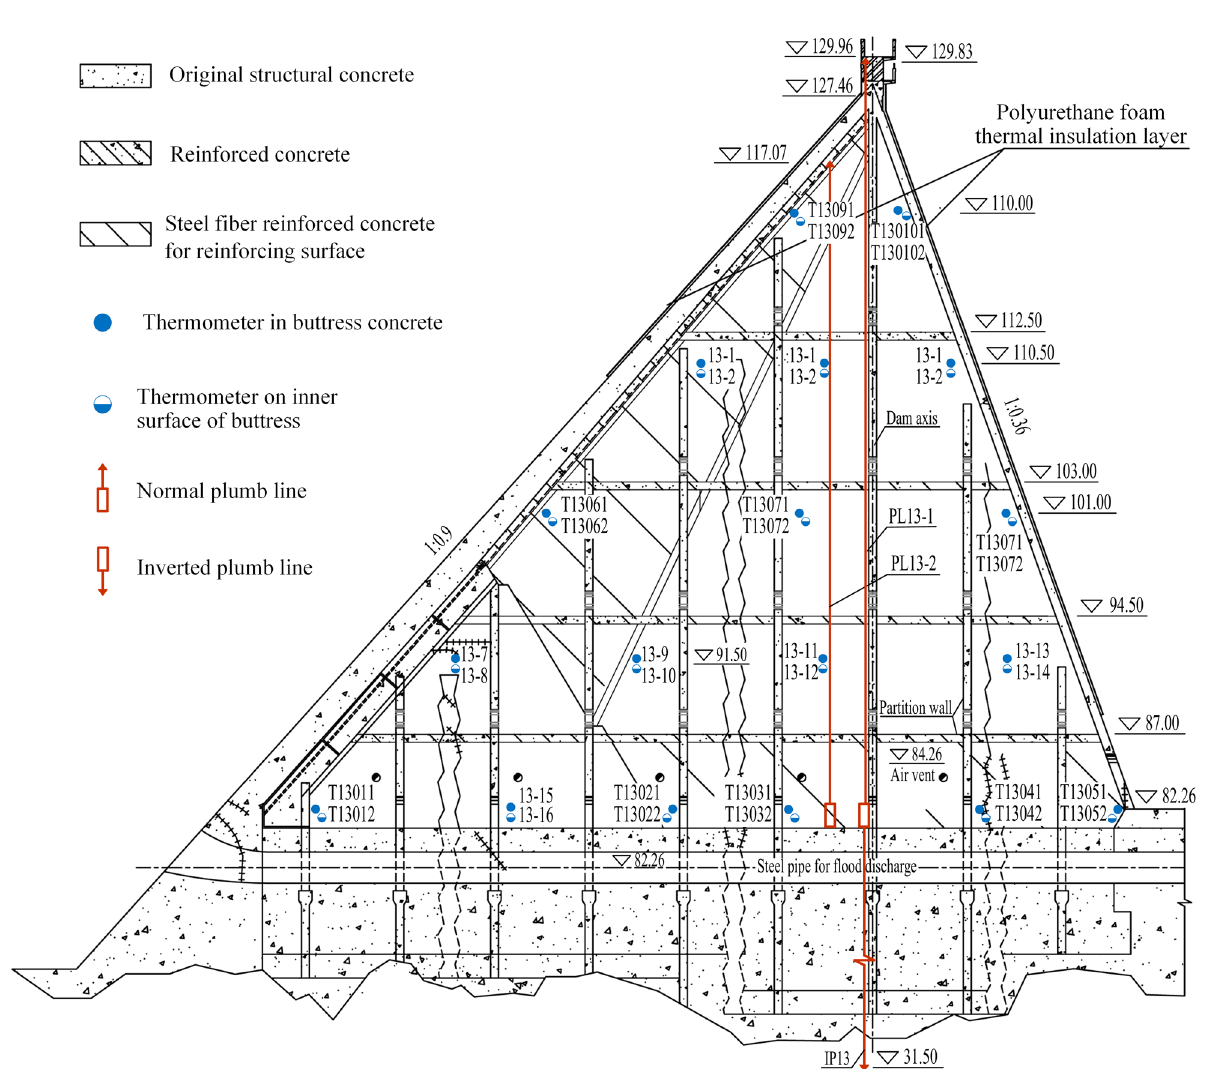
Figure 3. The vertical cross of No.13 buttress (unit: